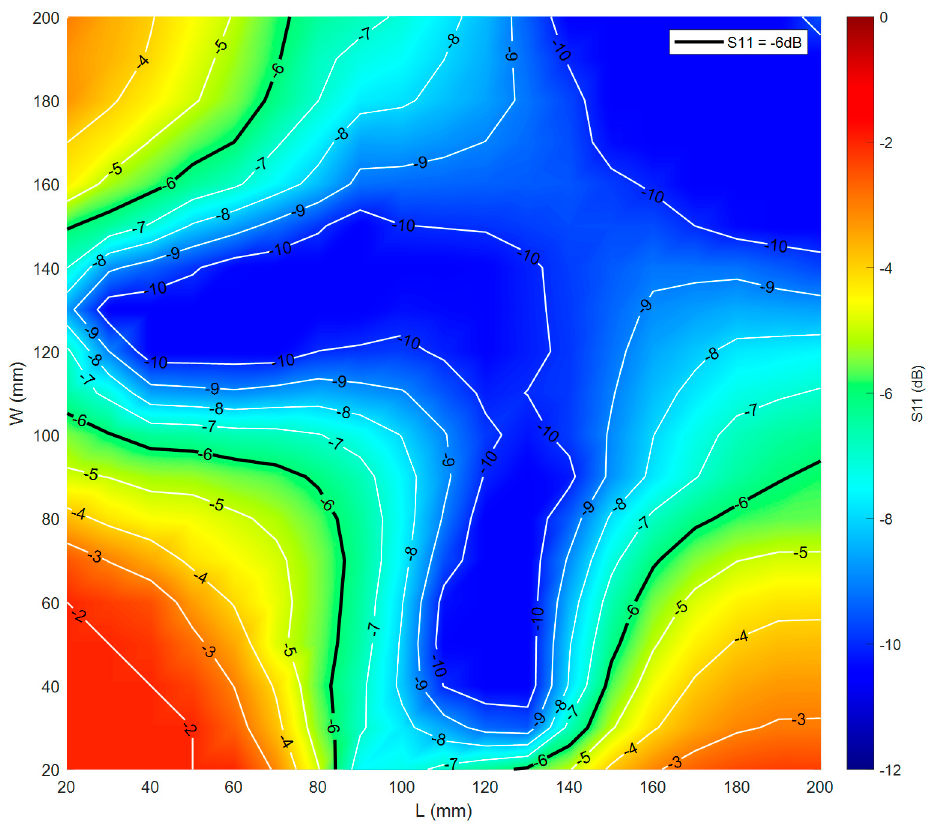
Figure 7. The cluster of ground planes with an S 11 ≤ − 6 dB corresponds to those cases within the − 6 dB contour line. L and W represent the length and width of the ground plane, respectively.